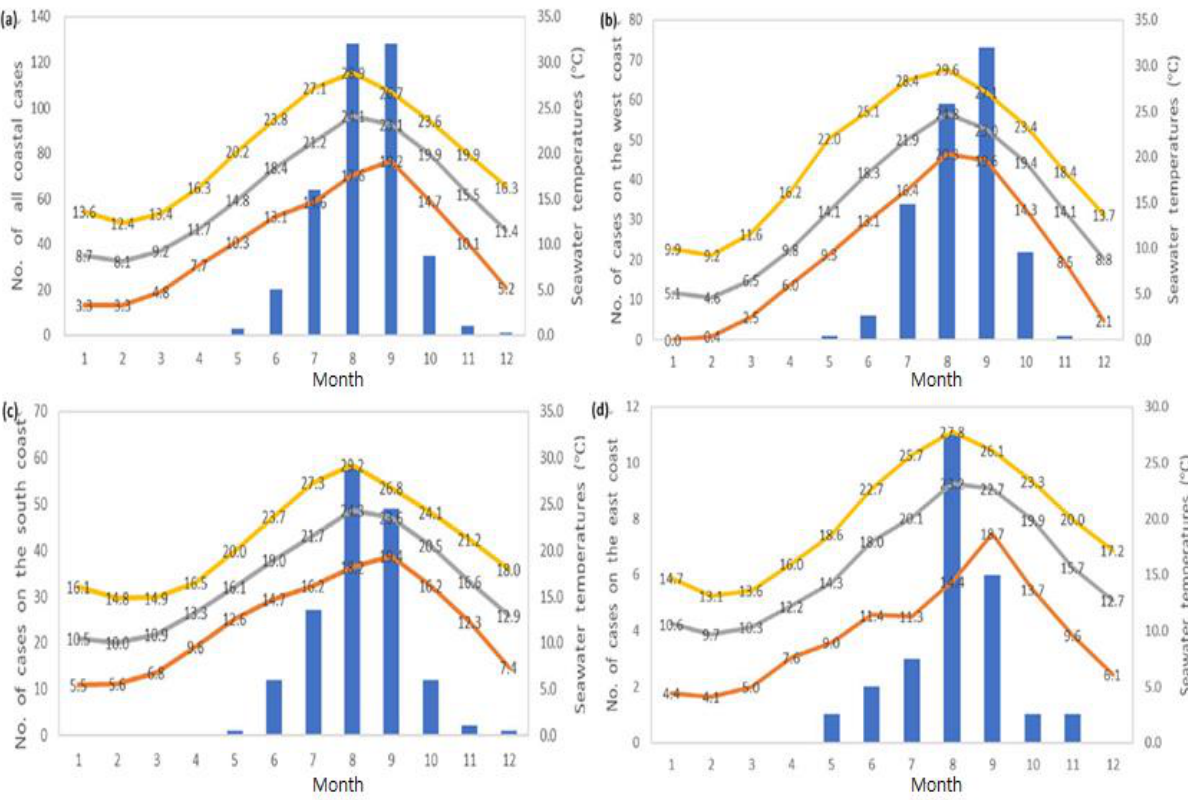
Figure 3. Number of V. vulnificus cases and seawater temperatures by month from 2003 to 2016. ( a ) Total cases of all coasts, ( b ) west coast, ( c ) south coast, and ( d ) east coast. Blue bar represents the monthly number of cases, yellow line: maximum seawater temperature, gray line: average seawater temperature, red line: minimum seawater temperature. Table 3. Correlation between seawater temperature indicators and V. vulnificus